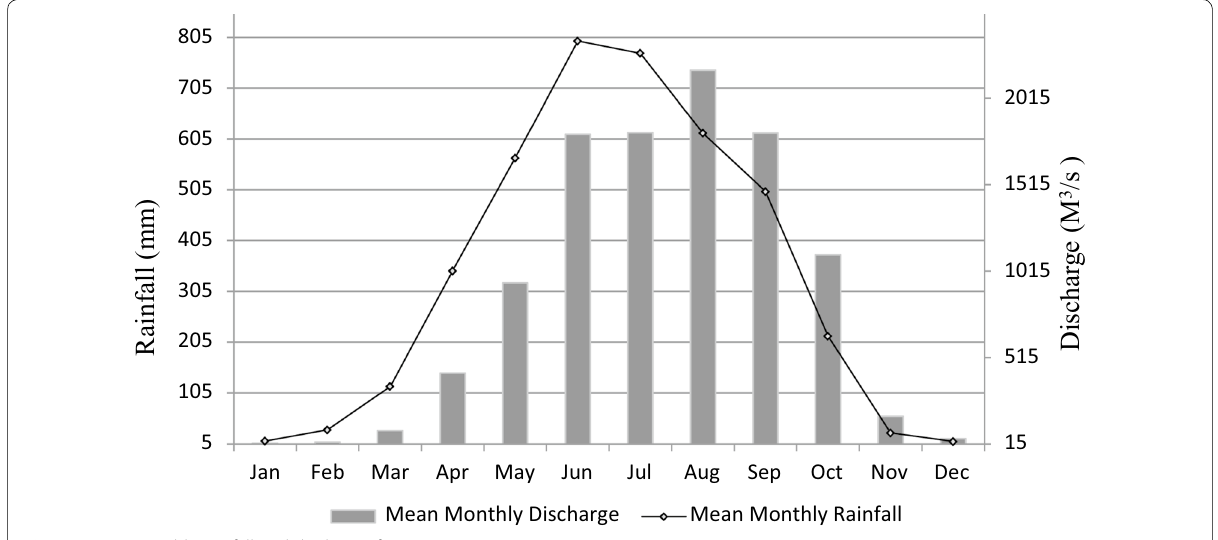
Fig. 2 Mean monthly rainfall and discharge from 1973 to